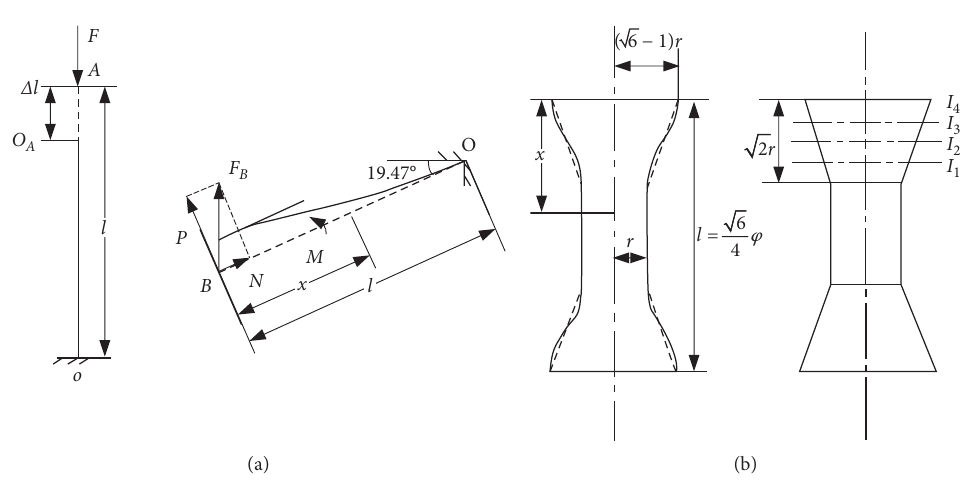
Figure 8: Force analysis and profile simplification of